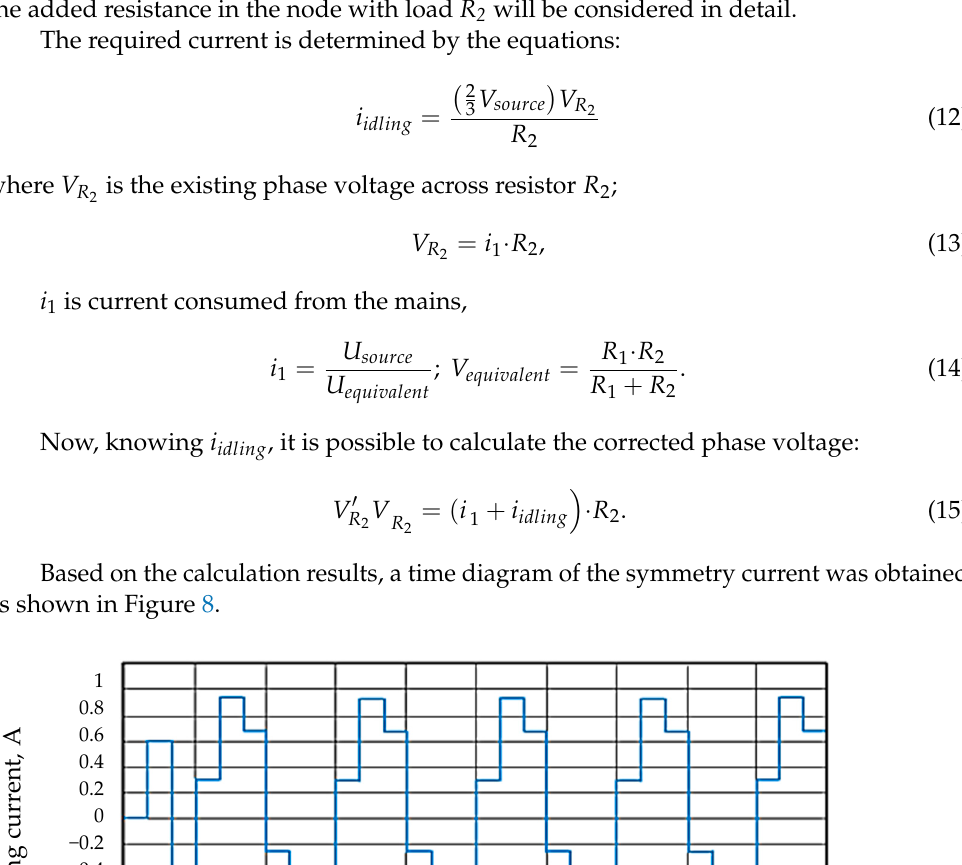
Figure 7. Initial substitution diagram without symmetry ( a ) and equivalent substitution diagram with symmetry ( b ).